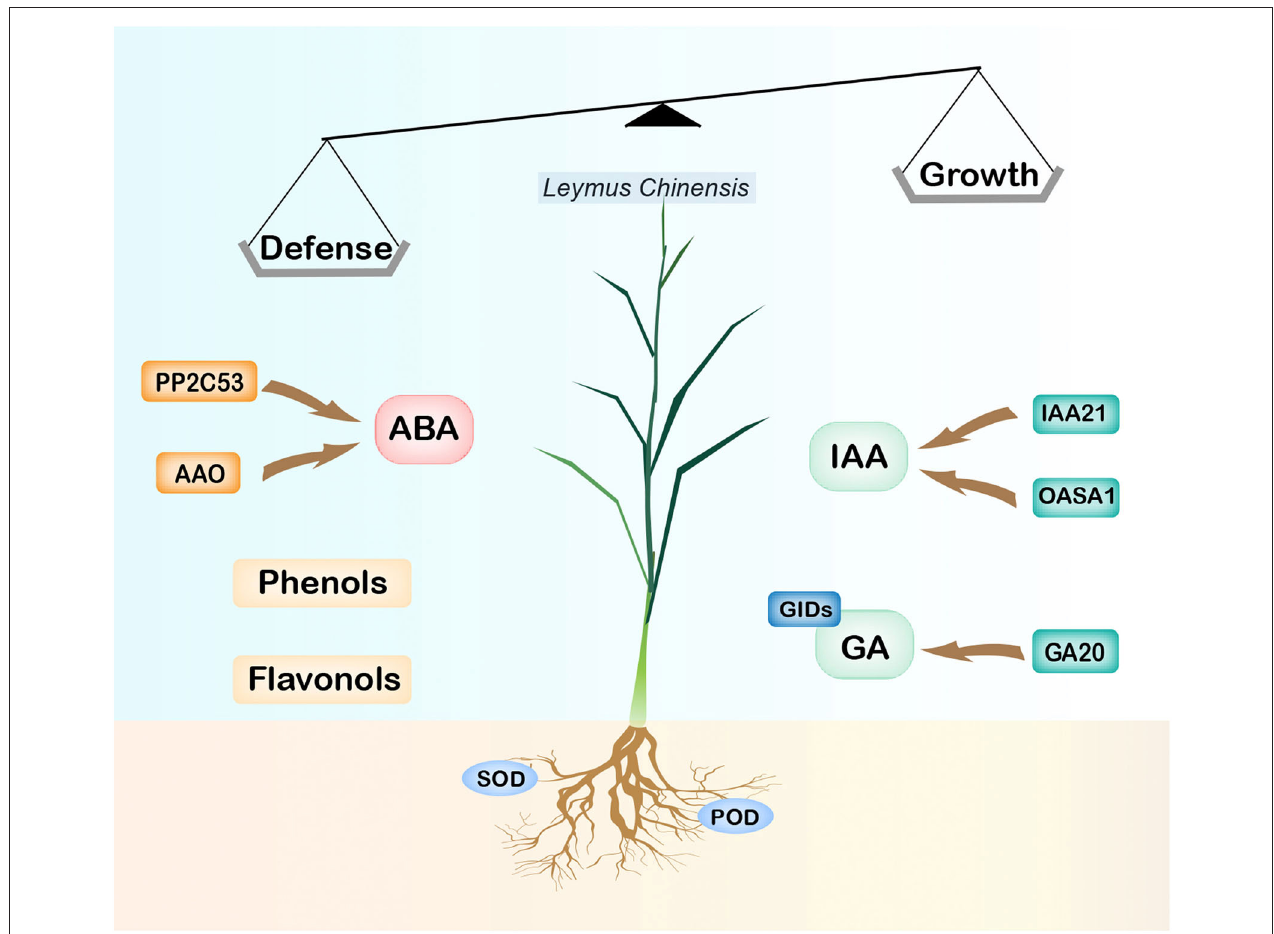
FIGURE 6 | A model for the mechanisms under long-term OG stresses. For the downregulation of synthetic genes OASAs, G20, and receptor protein genes GIDs, the contents of IAA and GA are reduced, thus limiting plant growth; the increase of the ABA level induced individual defense and further inhibited plant growth. The contents of flavonoids and phenols in leaves increased, while the activities of superoxide dismutase (SOD) and peroxidase (POD) in roots